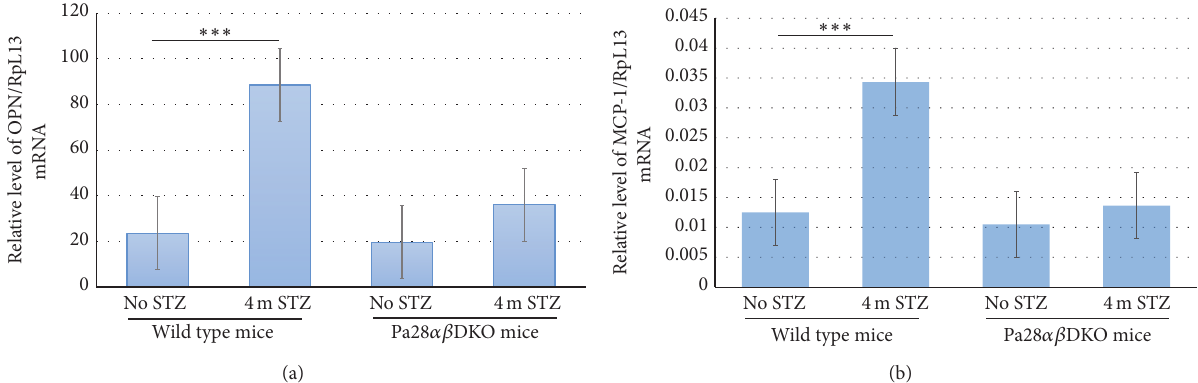
Figure 3: Deletion of the PA28 𝛼 and PA28 𝛽 genes suppresses the glomerular expression of OPN and MCP-1 in STZ-injected mice. (a) qPCR analysis of OPN and (b) MCP-1 mRNA in wild type and Pa28 𝛼𝛽 DKO glomeruli without or with four months of STZ injection. 𝑛 = 3 per group. Results presented as mean ± SEM. ∗∗∗ 𝑝 < 0.001 .